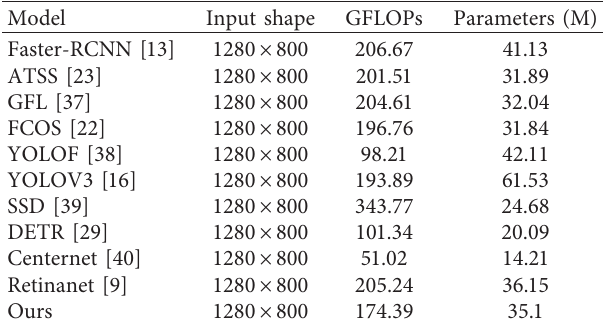
Table 3: Model complexity